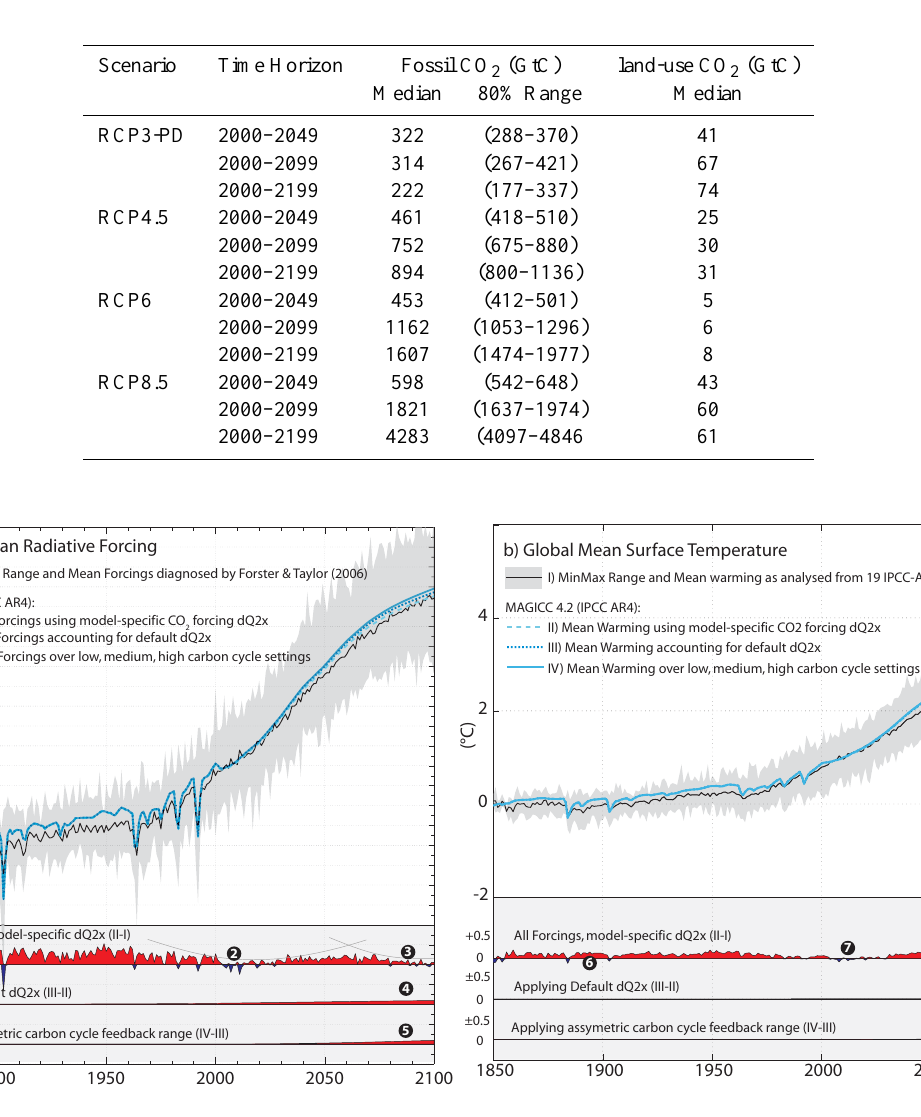
Fig. 5. Net radiative forcing (panel a ) and global-mean surface temperatures (b) for the SRES A1B scenario using MAGICC4.2 as presented in IPCC AR4. The standard radiative forcing used by MAGICC4.2 is compared to the means across all 19 CMIP3 AOGCMs, as diagnosed by Forster and Taylor (2006) (panel a ), resulting in an apparently relatively close agreement (see text). In contrast, the AOGCM-specific subsets of forcings used in calibrating MAGICC6, as shown in Fig. 1, are lower towards the end of the 21st century. For temperature, the MAGICC4.2 emulations are shown compared to the means diagnosed from the matching set of 19 CMIP3 AOGCMs. See text for discussion (black circled numbers). As presented in IPCC AR4 (see Fig. 10.26 in Meehl et al., 2007), the MAGICC 4.2 temperature data shown here are given relative to a 21-year mean around 1990 of 0.52 ◦ C above 1861–1890 (Brohan et al., 2006). The AOGCM temperature perturbations are shown relative to their control runs as a means to removing control run drift. The mean across AOGCMs relative to their control runs agrees well with the observational data around 1990, although there is a significant spread across AGOCMs (grey